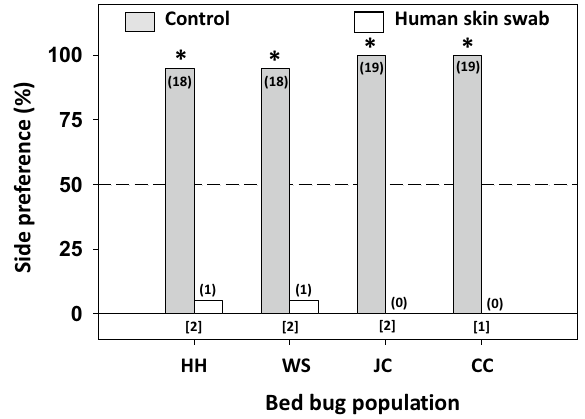
Figure 2. Responses of four bed bug populations to human skin swabs. An asterisk (*) indicates a significant preference for one side of the two-choice assay (Chi-square test, P < 0.05). The number of bed bugs that responded is indicated in parentheses for each choice, and the number of bed bugs that failed to respond (i.e., rested on neither tent) is indicated in brackets below each set of choices for each assay. HH = Harold Harlan, WS = Winston Salem, JC = Jersey City, CC = Courtyard.